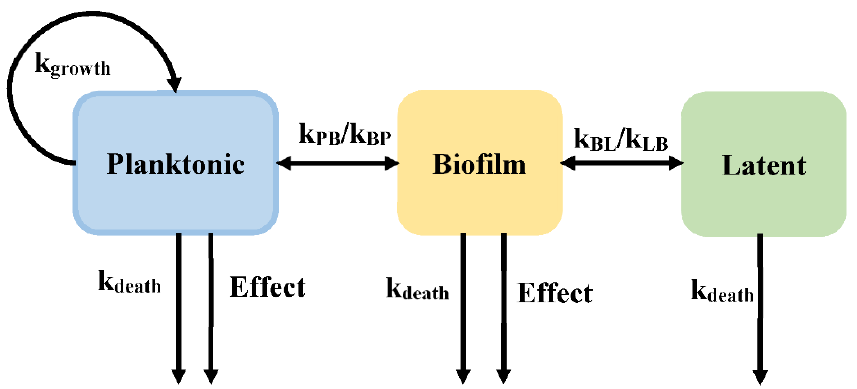
Figure 5. Schematic illustration of persistent resistance (Model 3).